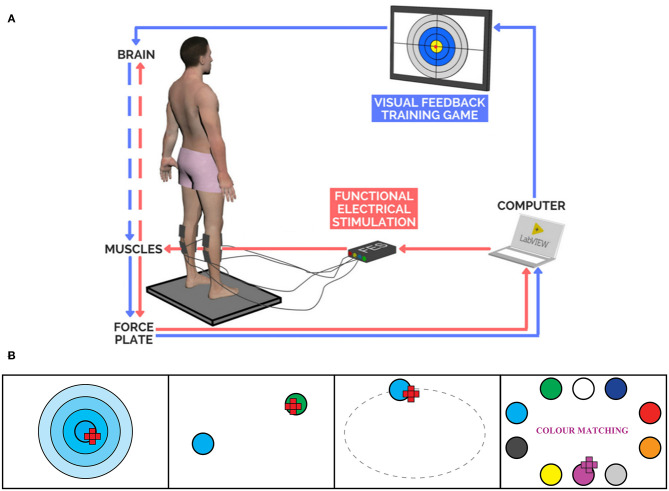
(A) FES+VFBT System (25). (B) Interfaces of VFBT Exercises: Bullseye, Hunting, Ellipse, and Color Matching, respectively from left to right.